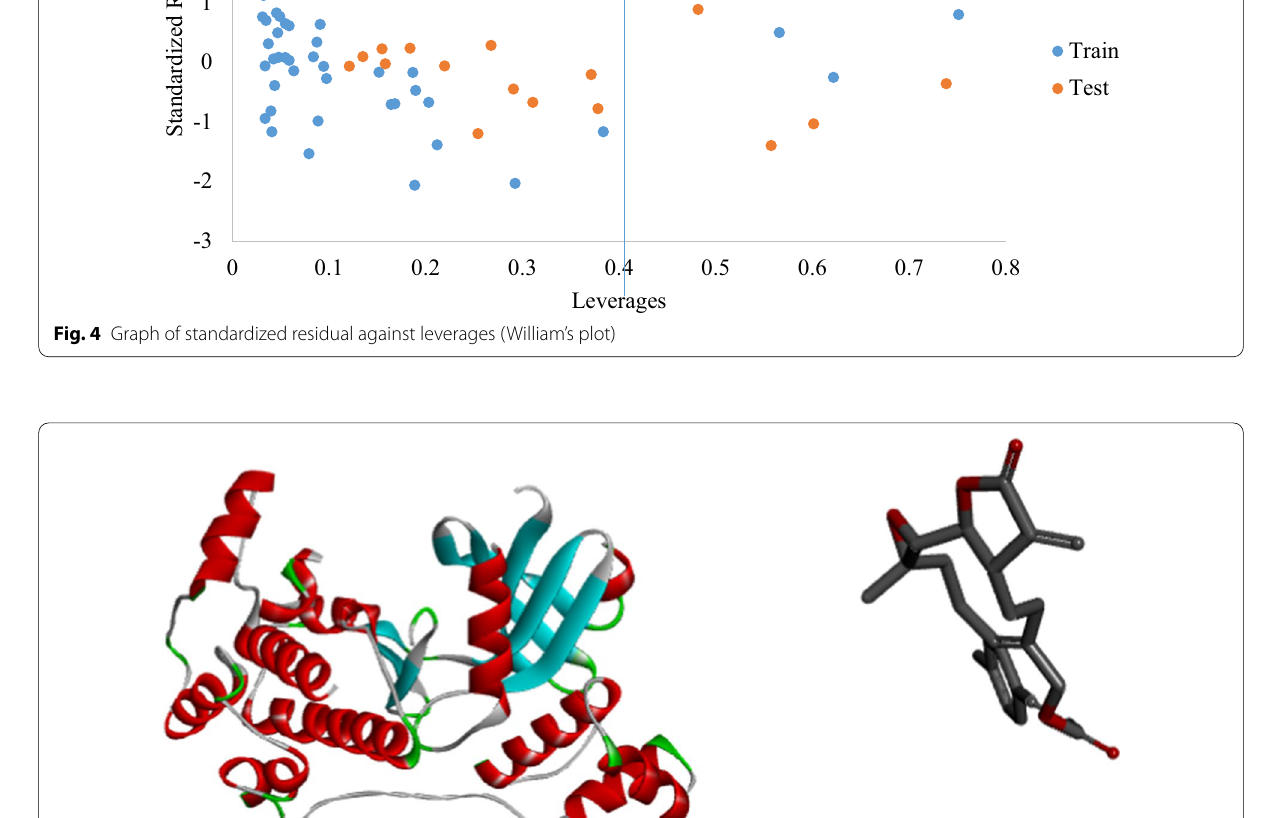
Fig. 5 Prepared receptor and ligand